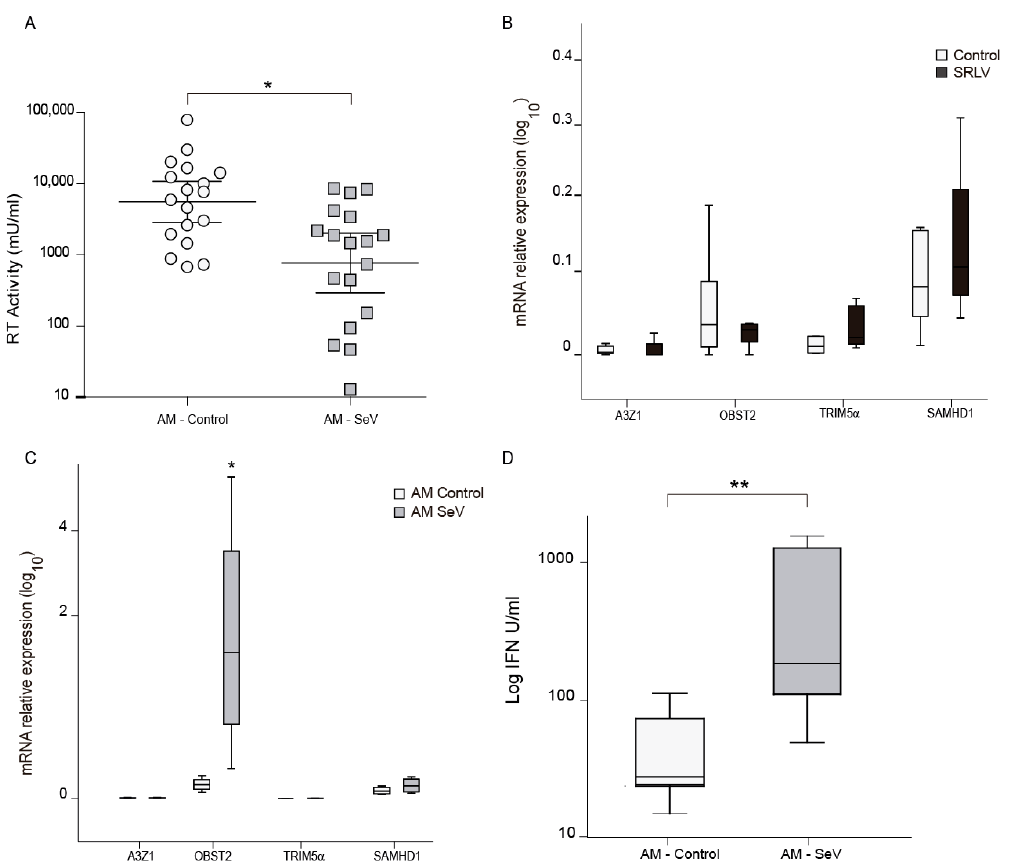
Figure 6. Antiviral activity induction after infection with Sendai virus (SeV). ( A ) RT activity in ovine skin fibroblasts (OSFs) cultured with supernatants from alveolar macrophages (AMs), infected or not with SeV, were infected with SRLV after 24 h of supernatant treatment. SRLV virus production was measured as retrotranscriptase (RT) activity in the supernatant at 72 h post infection. Data shown are the geometric mean ±95% CI of at least three independent experiments. Differences were statistically analyzed using unpaired T test, * p < 0.05. ( B ) Relative mRNA expression of the restriction factors after infection with SRLV. Data shown are the mean ± SEM of at least three independent experiments. * p < 0.05 (paired Mann–Whitney U test). ( C ) Relative mRNA expression of restriction factors: ovine APOBEC3Z1 (A3Z1) tetherin (oBST2), TRIM5 α , and SAMHD1 measured by quantitative RT-PCR in ovine skin fibroblast (OSF) cultured with supernatants from AM control or AM infected with SeV. Values are the median (±interquartile range) of at least three independent experiments. * p < 0.05 (Mann–Whitney paired U Test). ( D ) Type-I interferon (IFN) quantification measured by an ovine-adapted IFN bioassay using supernatants from AM control or infected with SeV. Data shown are the median ±interquartile range of at least three independent experiments. * p < 0.05, ** p < 0.01 (Mann–Whitney paired U test).